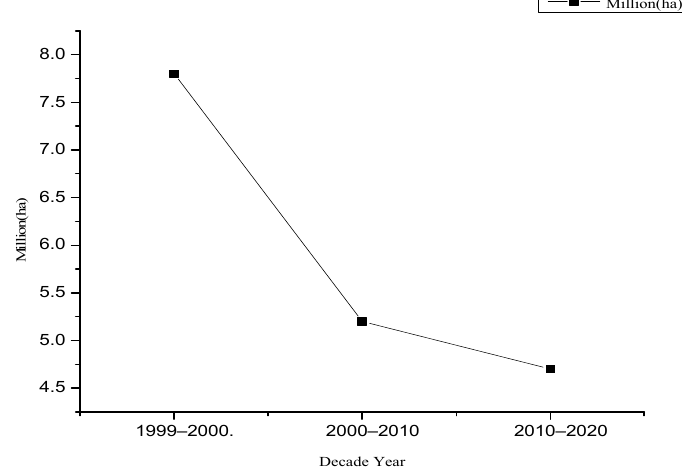
Figure 3. The global net shift in the annual forest area (Million ha). Source (FAO, 2020).